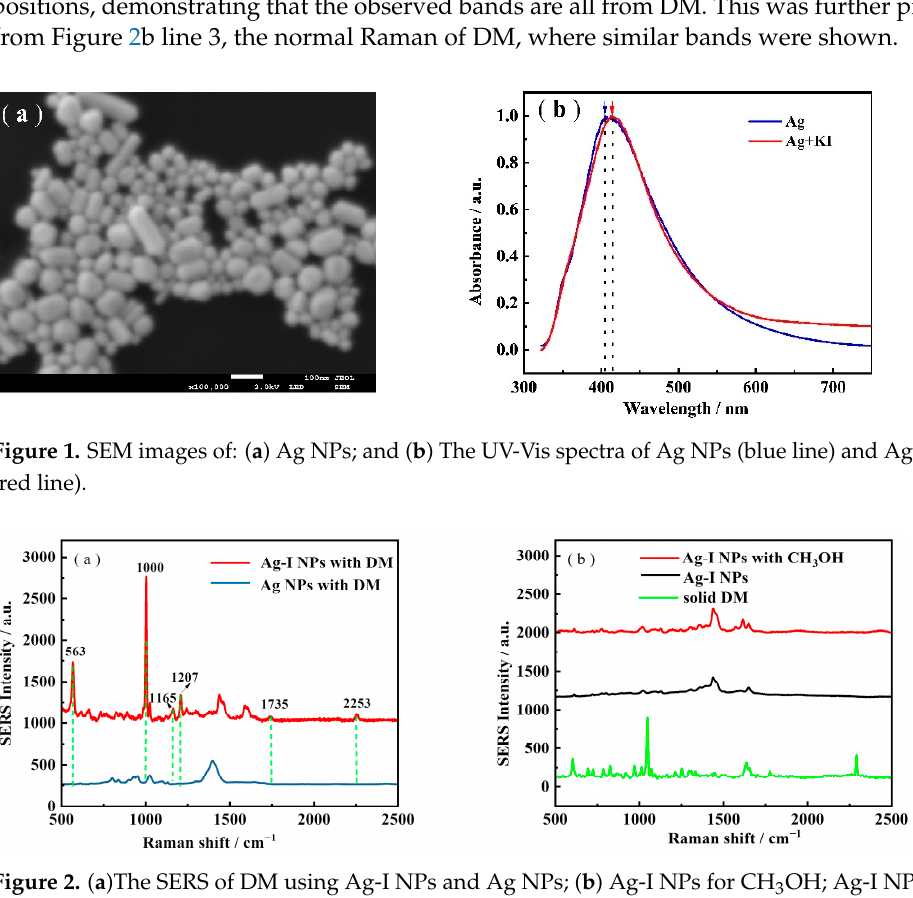
Figure 1. SEM images of: ( a ) Ag NPs; and ( b ) The UV-Vis spectra of Ag NPs (blue line) and Ag-I NPs (red line).